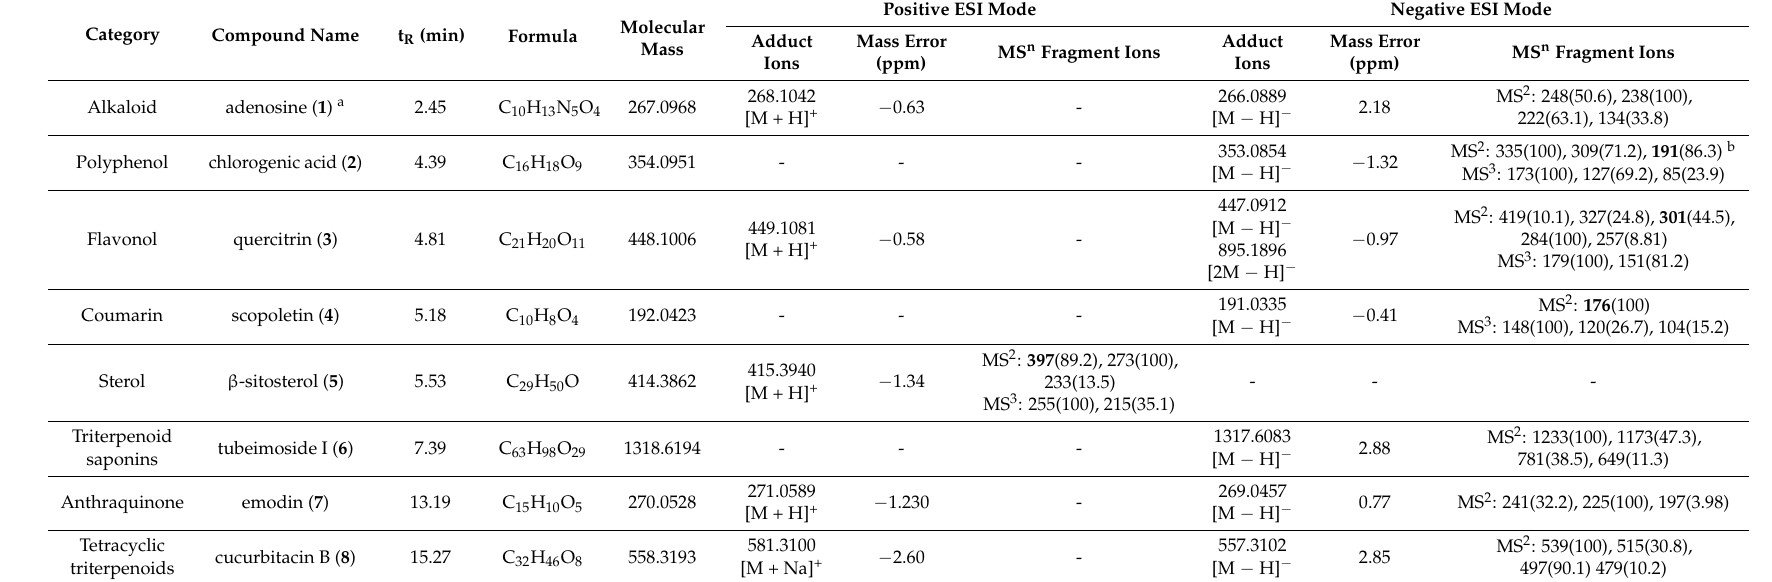
Table 1. The UPLC-MS n data of eight representative reference compounds in Bolbostemma paniculatum